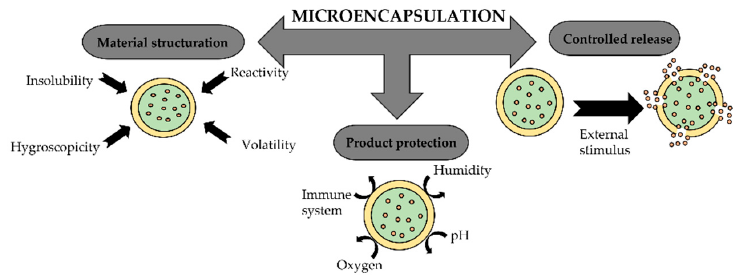
Figure 7. Objectives of microencapsulation.